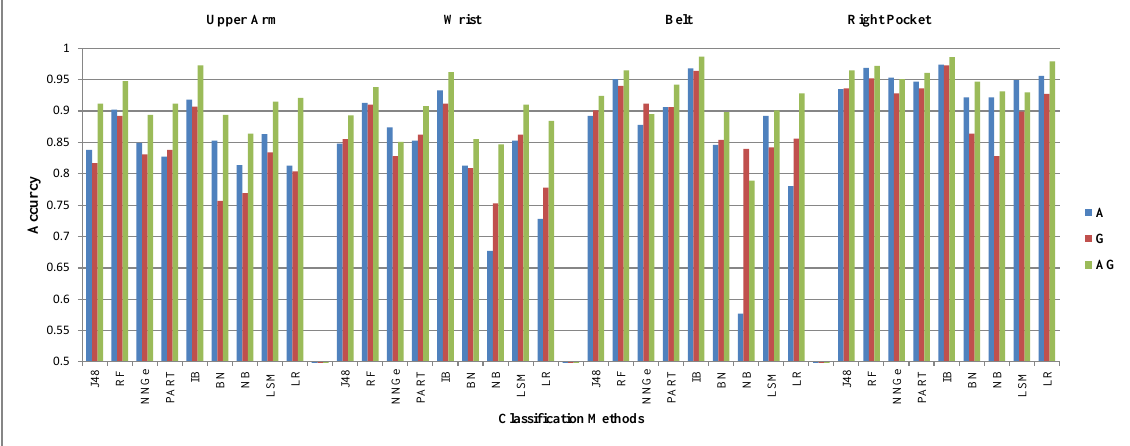
Figure A.1. Recognition performance for the walking activity at all four positions using